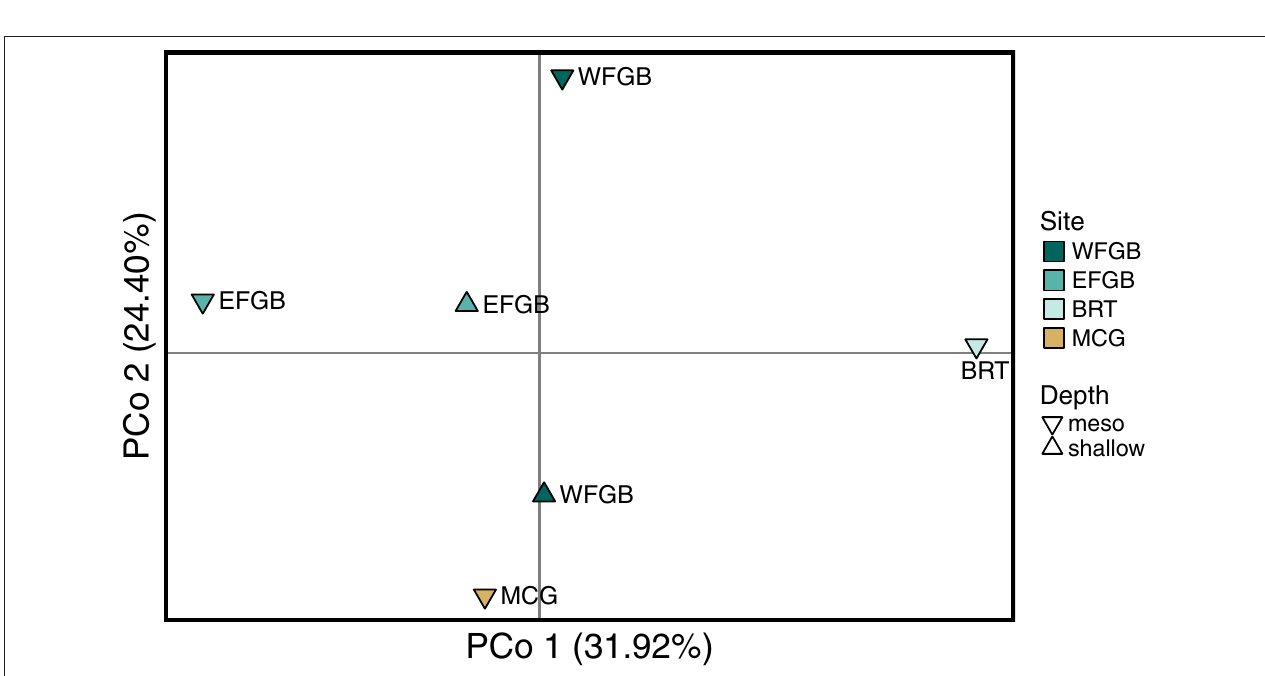
FIGURE 2 | Pairwise comparisons of population differentiation as measured by fixation index (F ST ). The level of differentiation among populations is shown in increasing intensities of red. Significantly differentiated F ST estimates are shown in larger black font ( p < 0.05 after FDR correction).